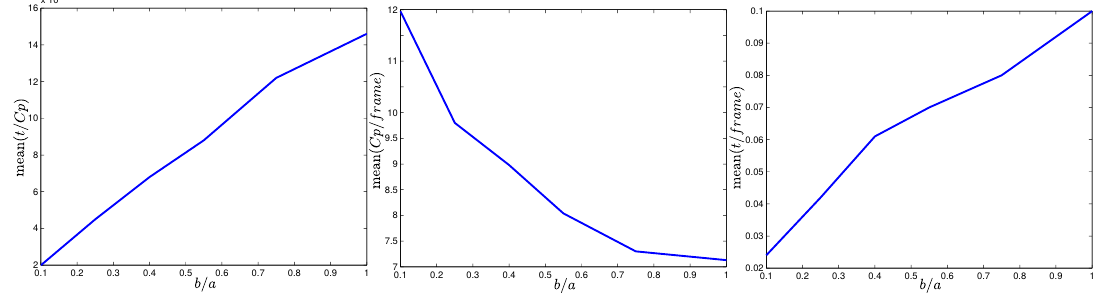
Figure 6. Results obtained by means of the variation of the relation between ellipse S c axes ( b / a ). ( left plot ): average tracking time for a candidate point; ( middle plot ): average number of candidate points being tracked at each frame; ( right plot ): average total time per frame. These results were obtained using the same methodology described in Section 4.2.